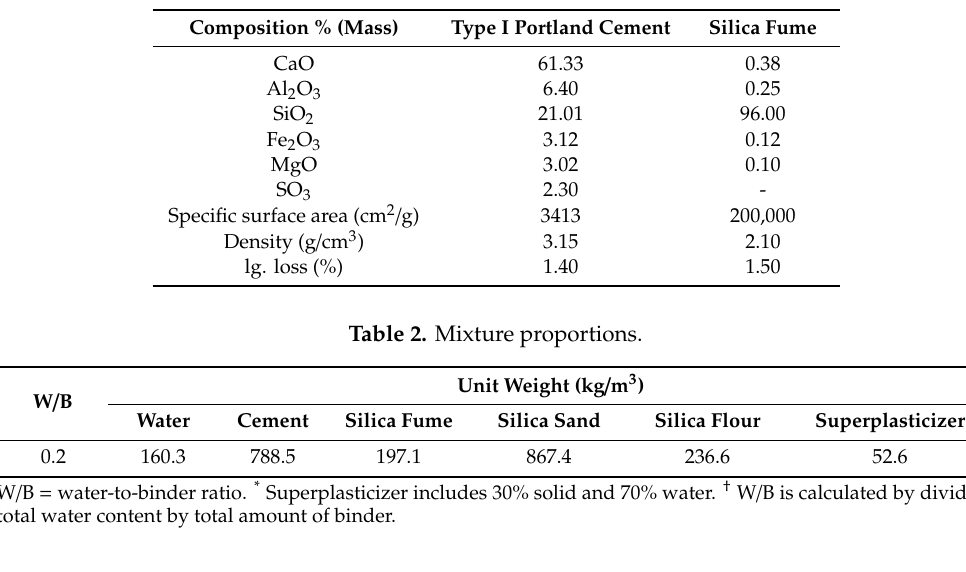
Table 1. Compositions and properties of cementitious materials.